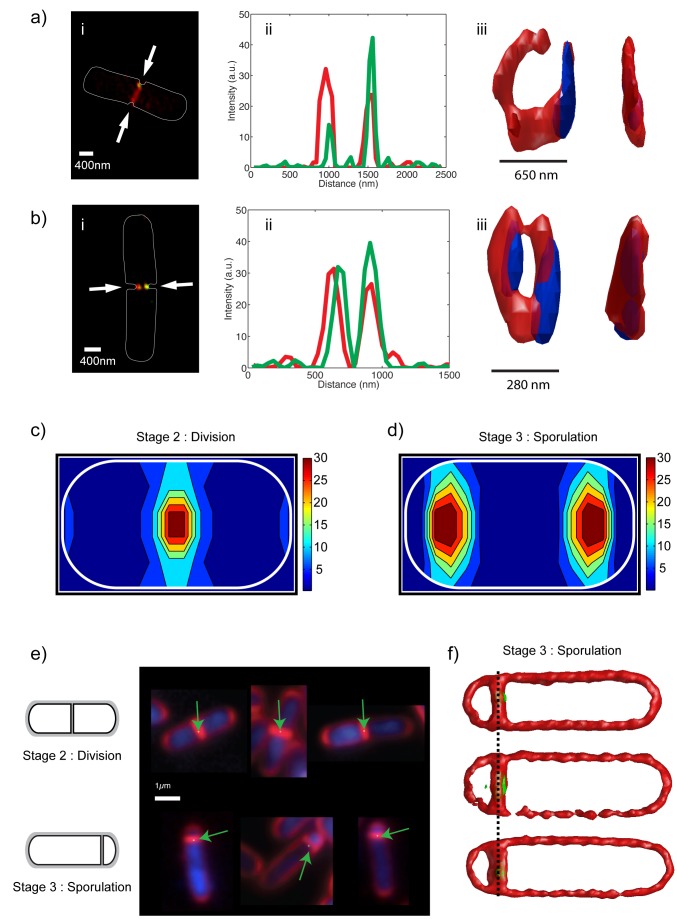
SpoIIIE clusters localize to the FtsZ ring in invaginating cells and to the septal midplane in dividing and sporulating cells.(a–b) (i) 3D-SIM imaging of SpoIIIE (green) and FtsZ (red) at two stages of septal constriction show that SpoIIIE clearly localizes to the FtsZ ring throughout the process of invagination (55% of cells, N = 78). Solid white line represents cell contour. (ii) A line scan of the fluorescence signal across the FtsZ ring (white arrows in panel i) shows that SpoIIIE fluorescence signal (green) overlaps to that of FtsZ (red). (iii) A 3D reconstruction of the FtsZ ring (red) and SpoIIIE (blue) is obtained by calculating a constant fluorescence intensity profile. Front (right) and side (left) views are shown. The size (FWHM) of the ring is 650 nm in (a-iii) and 280 nm in (b-iii). (c–d) Heat maps of PALM-limited clusters in (c) dividing (N = 87) and (d) sporulating (N = 180) cells show a clear SpoIIIE localization to the center of the septal plane. Normalized localization probability distributions were calculated for the first quartile of the cell and then reflected into the other three quartiles to impose mirror symmetry in the axis perpendicular and parallel to the cell axis. The relative average number of clusters detected in each pixel of the grid is color-coded according to the color bar (right). White lines represent cells outlines. (e) Probability density representation of SpoIIIE localization in dividing (top panels) and sporulating (bottom panel) cells. (f) Reconstructions of 3D-SIM images of three sporulating cells during DNA translocation show that SpoIIIE clusters localize to the center of the asymmetric septal plane.